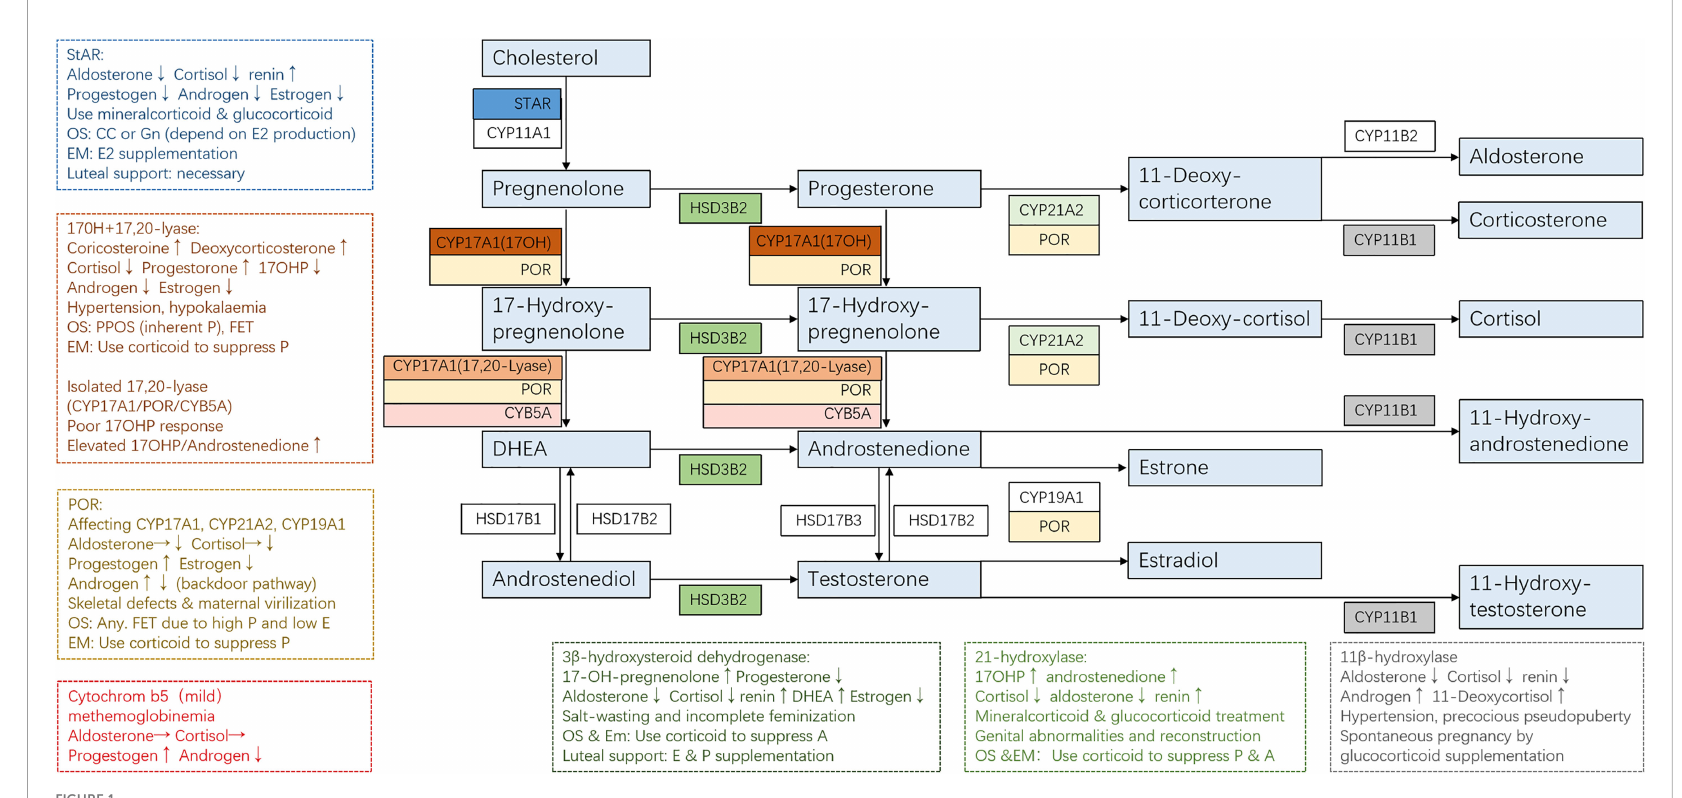
FIGURE 1 PRISMA fl owchart of literature search and selection. PRISMA, Preferred Reporting Items for Systematic Reviews and